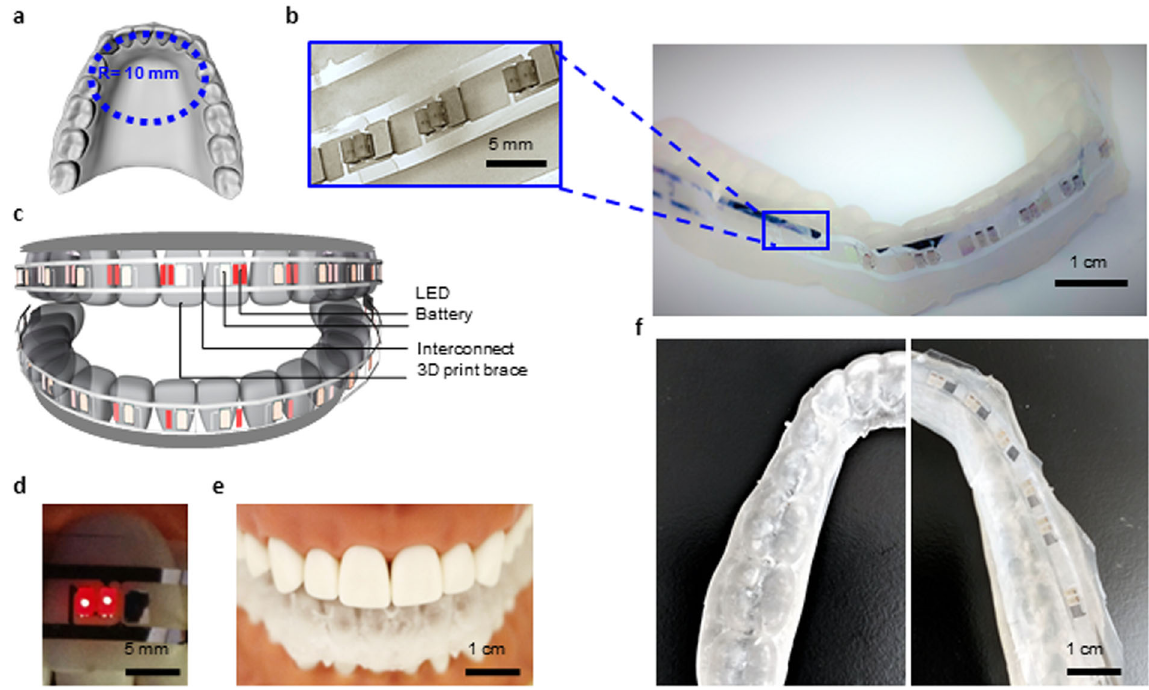
Fig. 5 Smart dental brace system. a Average minimalist radius of curvature can be obtained in dental arch is 10 mm. b Flexible battery module bonded to aluminum interconnects on PET substrate and its integration with chip-scale LEDs. The device is embedded in a 3D printed brace with battery and LED module repeated per each teeth. c Smart dental brace components: near-infrared LEDs integrated with fl exible batteries and interconnected on a soft PET substrate. The whole device is embedded in semi-transparent 3D printed brace, d Flexible battery powering near-infrared two LEDs connected in series. e Image of the smart dental brace device on arti fi cial teeth. f Top view of smart dental brace from the outside (left) and inside (right) with packaged red light therapy